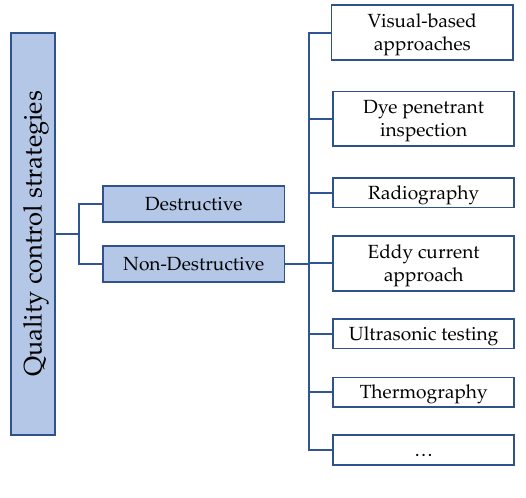
Figure 1. Categorization of the quality control